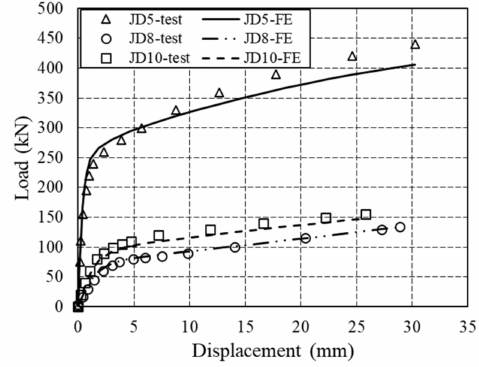
Figure 5. Verification of FE